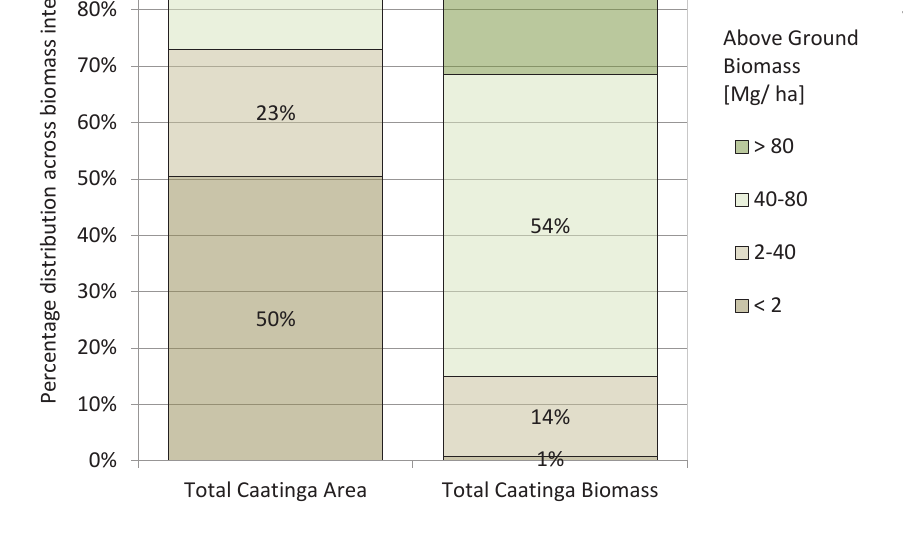
Figure 7. Fraction of the total Caatinga area in a given above ground biomass interval (left column) and the fraction of the total Caatinga AGB represented by each above ground biomass interval (right column).